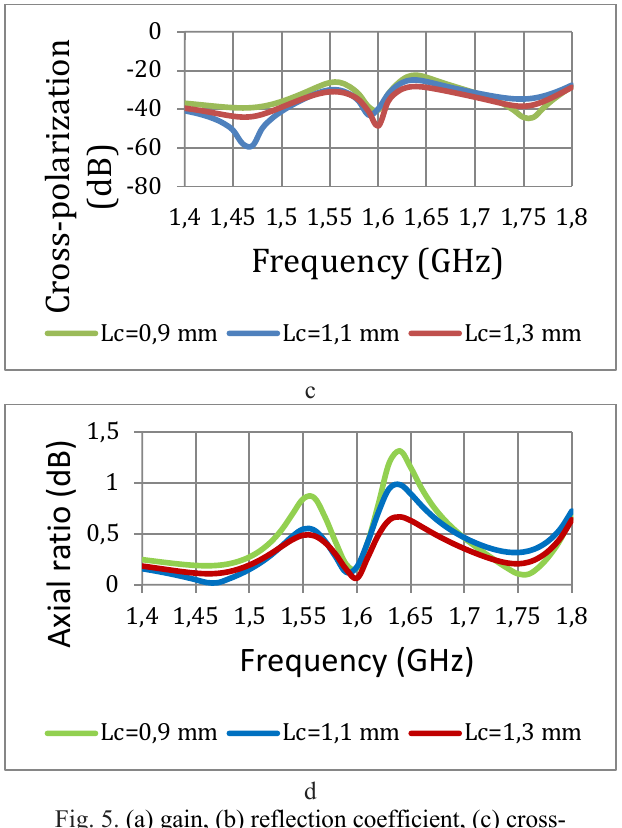
Fig. 5. (a) gain, (b) reflection coefficient, (c) cross- polarization, (d) axial ratio vs. frequency at L c = 0.9, 1.1, and 1.3 ( d c = 3.5)